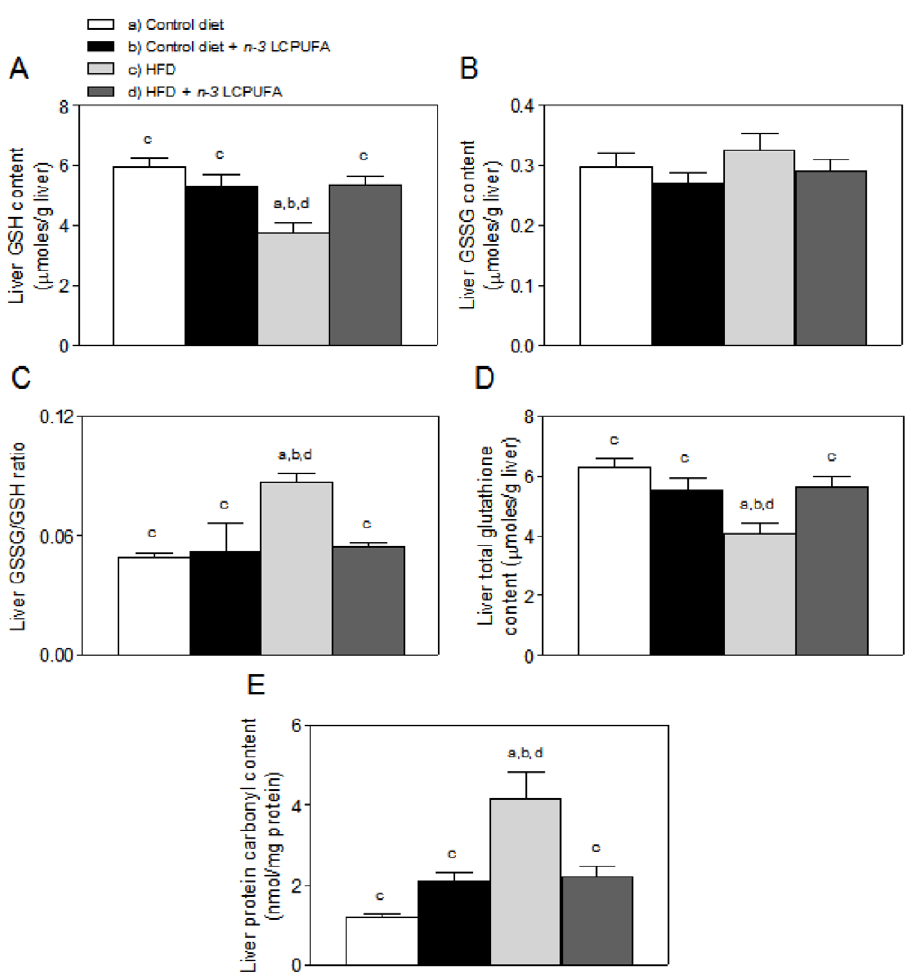
Figure 2. Effect of n-3 long-chain polyunsaturated fatty acid ( n-3 LCPUFA) supplementation in oxidative stress parameters. (A) Reduced glutathione (GSH), (B) oxidized glutathione (GSSG), (C) GSSG/GSH ratio, (D) total glutathione (GSH + 2GSSG), (E) and protein carbonyls. Values shown represent means 6 SEM for six mice per experimental group. Significant differences between the groups are indicated by the letters identifying each group ( P , 0.05; ANOVA and the Newman-Keuls’ test).